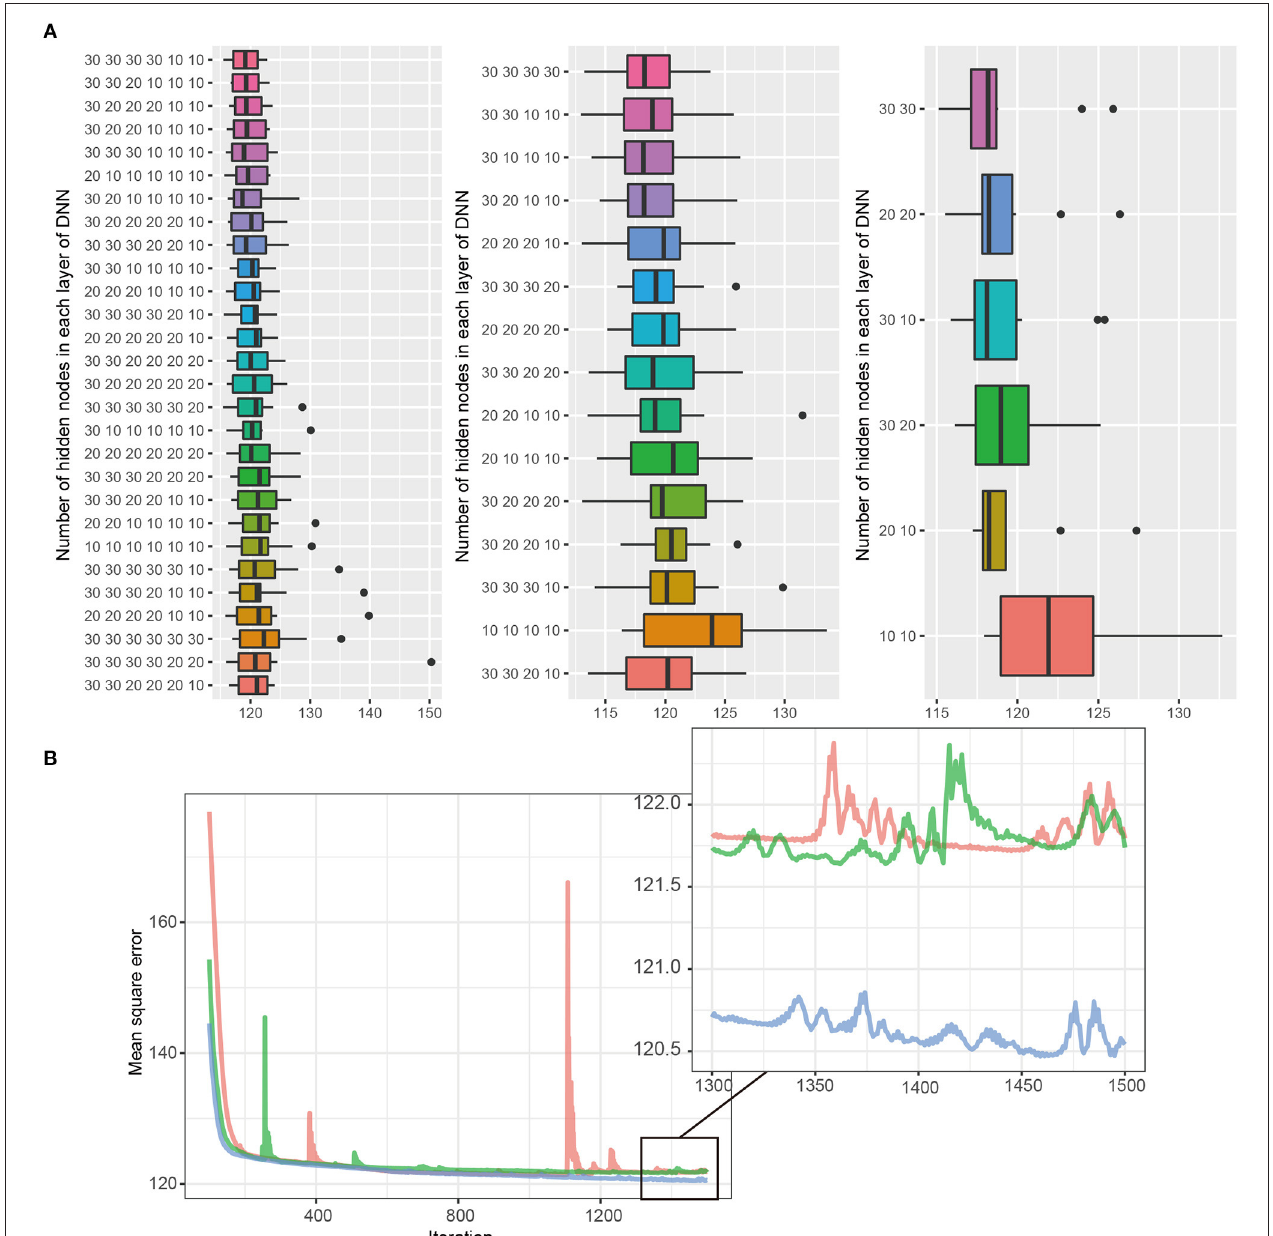
FIGURE 2 | (A,B) DNN model selection. The DNN consists of six hidden layers, four hidden layers, and two hidden layers, with 30 nodes in each layer. Black bars, upper margins, and maximum lines in each boxplot indicate the means, one standard deviation (SD), and 1.96 SD deviation values, respectively. The best DNN model among each layer was selected, and the tournament method was used to identify the final model. The 30, 30 in the two-layer model had the lowest MSE and was selected as the final